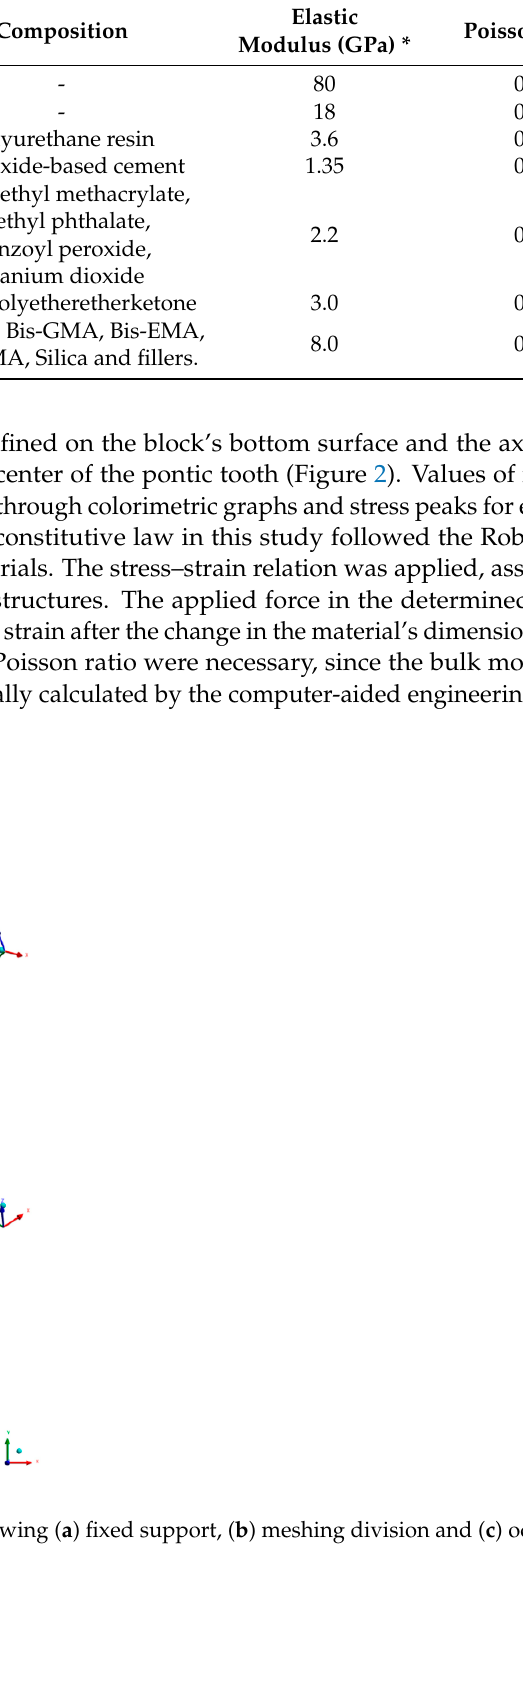
Table 1. Mechanical properties of the materials/structures used in the current study.